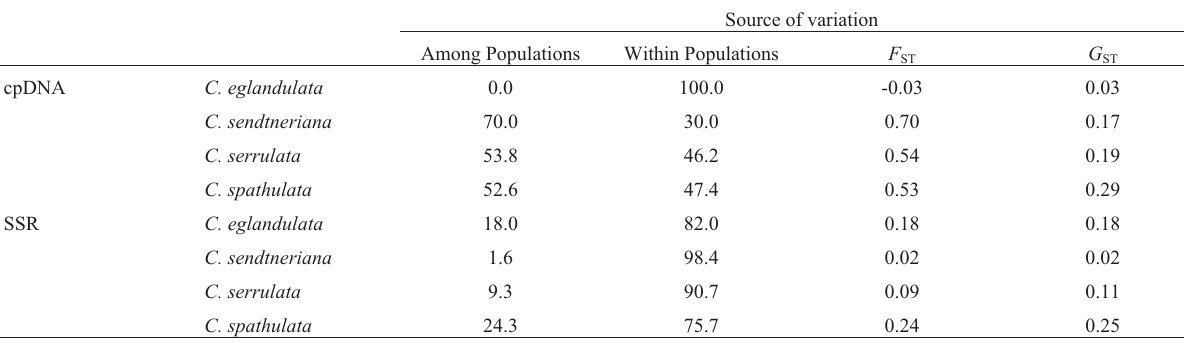
Figure 2 - Evolutionary relationships of plastid haplotypes found in four Calibrachoa species (A) C. eglandulata ; (B) C. sendtneriana ; (C) C. serrulata ; and (D) C. spathulata haplotypes. The circles represent haplotypes, and the diameter is proportional to the frequency across analyzed individuals per spe- Table 3 - Population structure based on plastid and microsatellite markers through AMOVA, F ST , and G ST